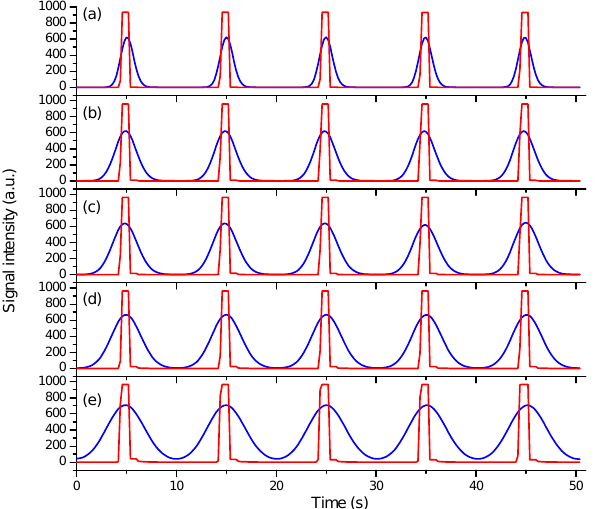
Fig. 3. Comparison of CO 2 signals between pumping CO 2 -spiked N 2 gas through the WASP tube (blue line) and pumping CO 2 -spiked N 2 gas directly into the LI-COR CO 2 analyzer (red line) under flow rates of: (a) 14Lmin − 1 , (b) 7.7Lmin − 1 , (c) 6.6Lmin − 1 , (d) 5.4Lmin − 1 , and (e) 3.9Lmin − 1 , which correspond to a ram air pressure of 110, 50, 40, 30, and 20mbar in front of the WASP tube, respectively.